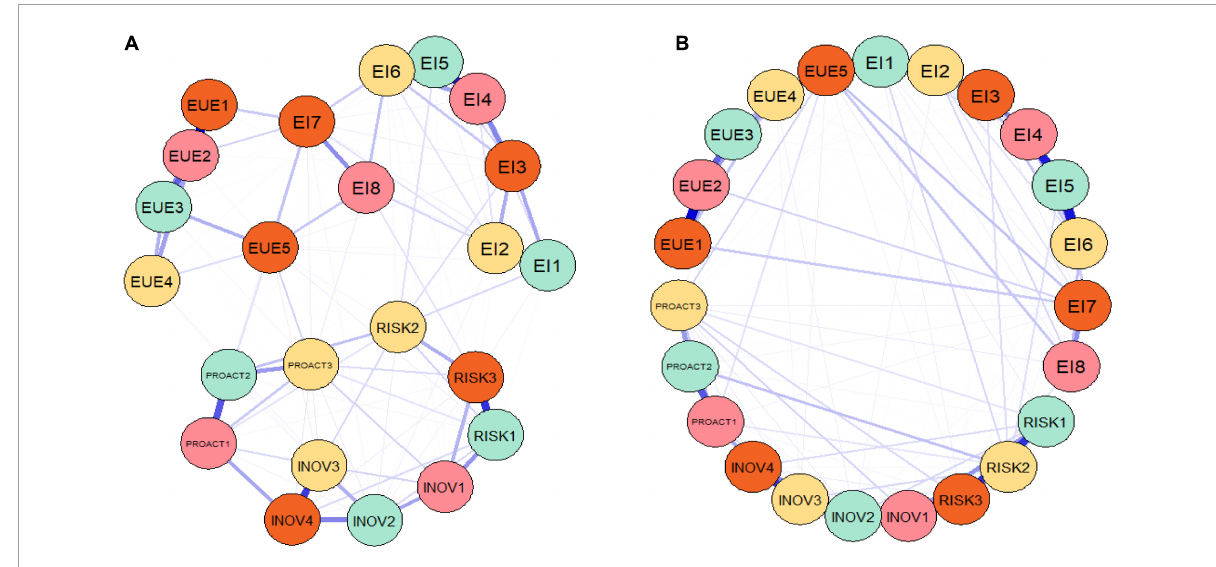
FIGURE5 Results of the GGMs processed on the entire sample. (A) EBICglasso method. (B) PCOR method. Authors’ research in RStudio.